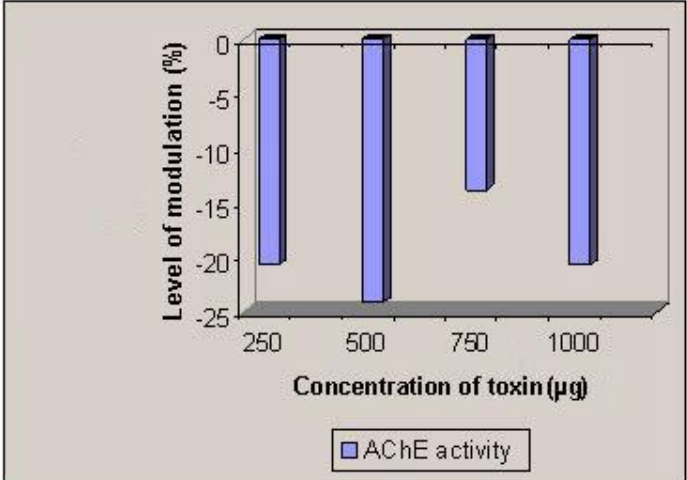
Figure 6. Modulation of AChE activity by the aqueous extract of Halichondria panicea